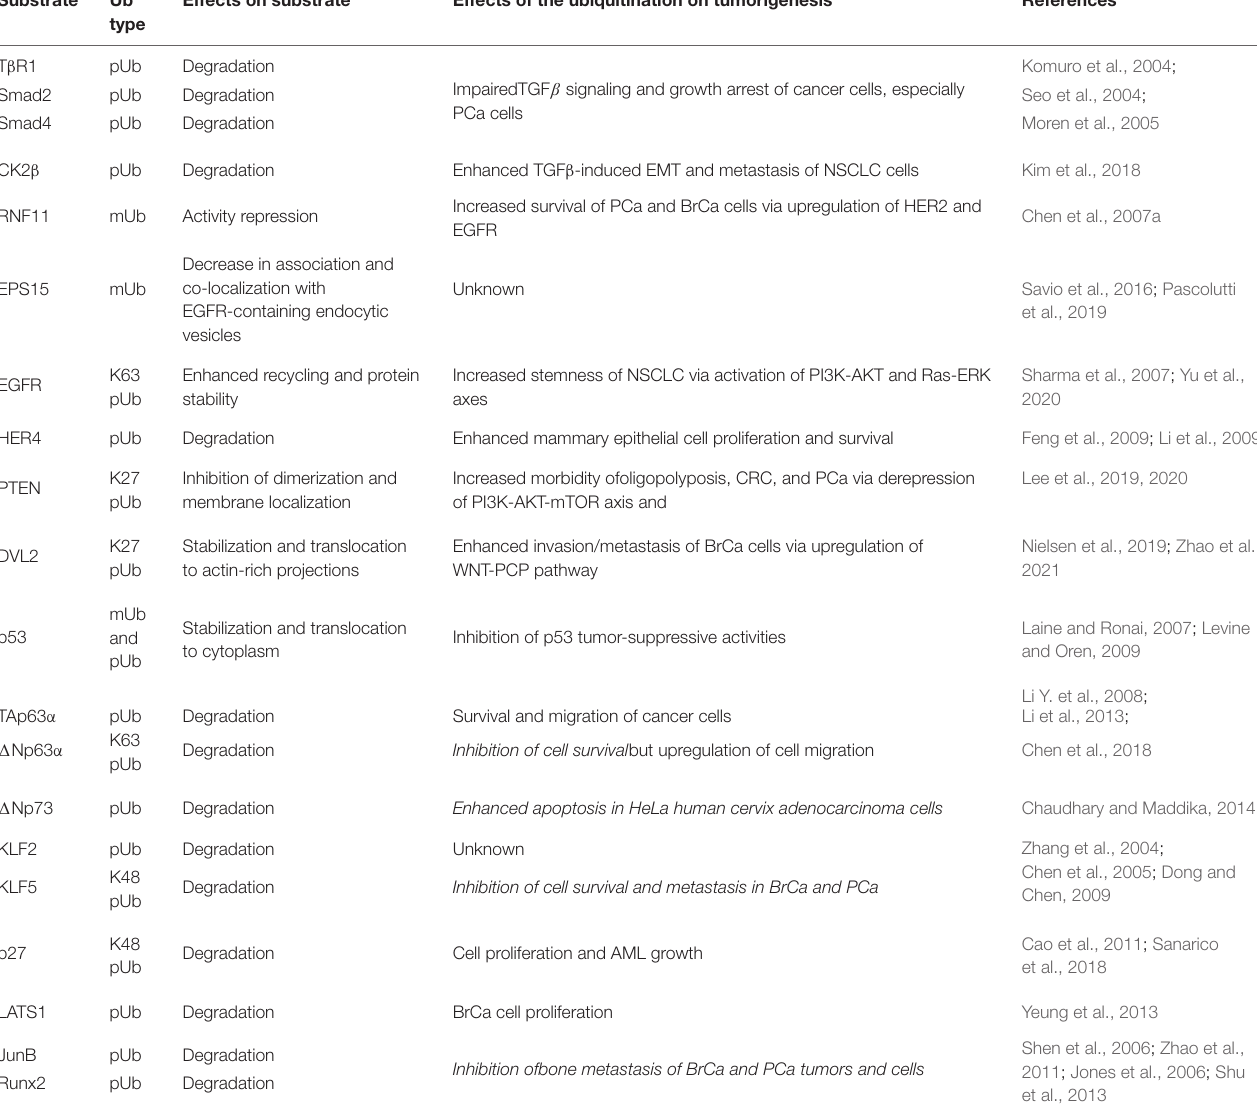
TABLE 2 | WWP1-mediated protein ubiquitinations and their effects on tumorigenesis.